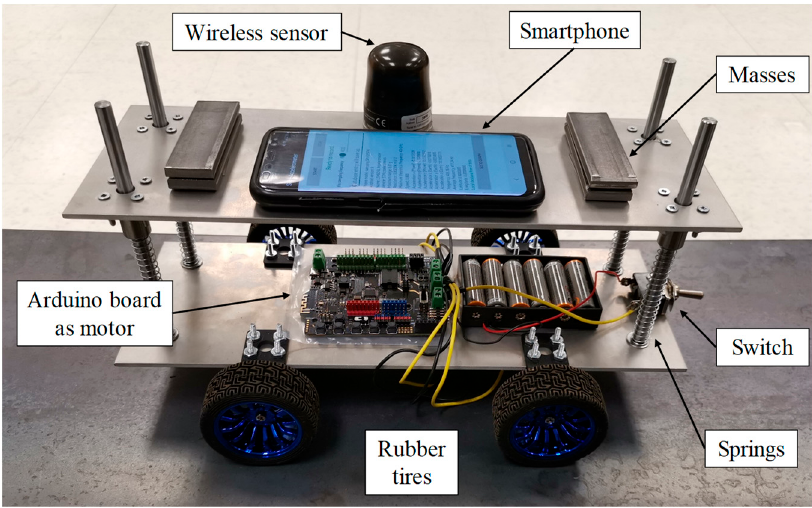
Figure 8. The custom-designed and -built robot car.